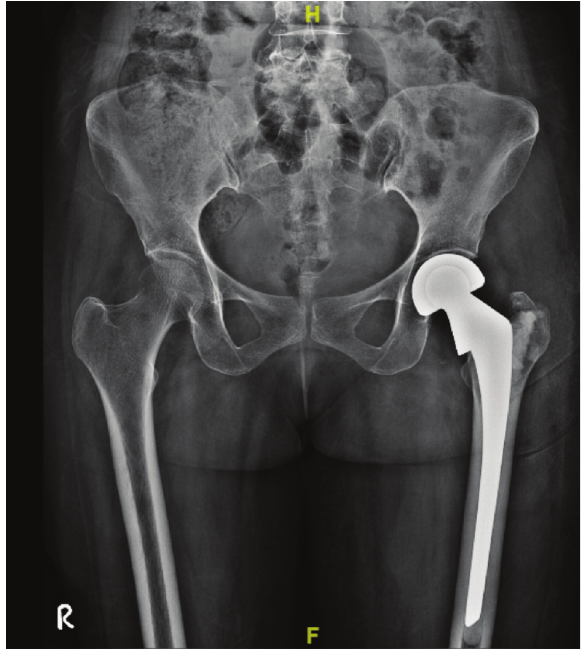
Sciatic nerve after